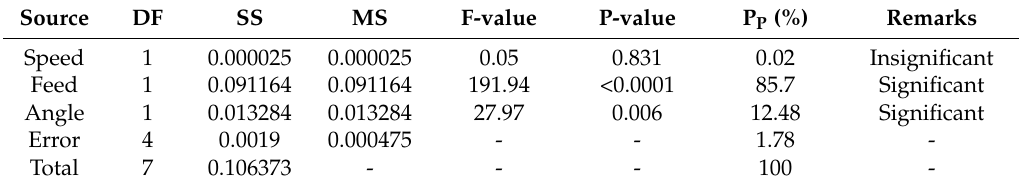
Table 10. ANOVA results for the tool distance from exit edge at pivot-point appearance time.